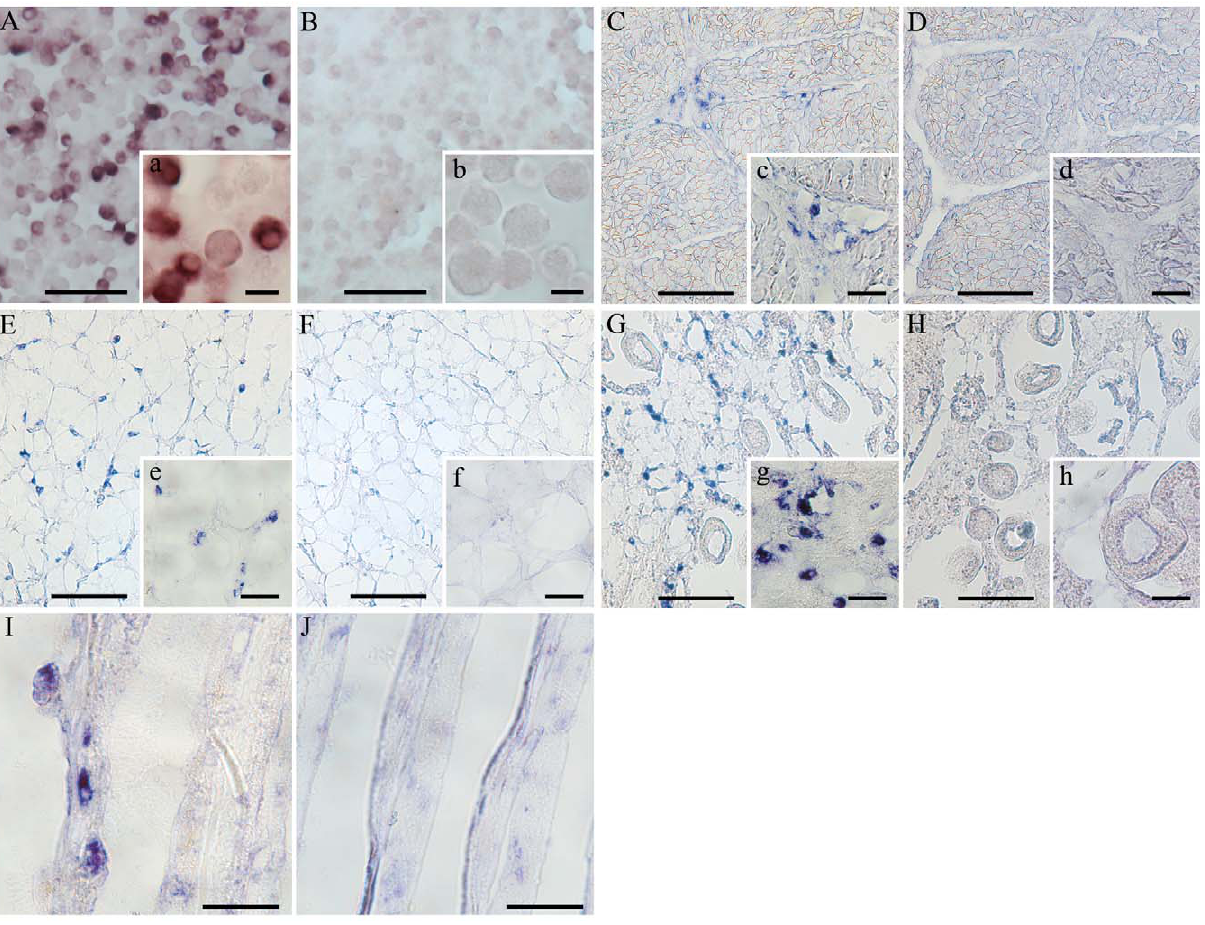
Figure 1. Myt C expression in mussels at the mRNA level. ISH in hemocytes, muscle, connective tissue, gonad and gills from mussel using the myticin antisense RNA probes (A, C, E, G and I, respectively). Control samples were hybridized with the sense probes (B, D, F, H and J, respectively). Scale bar: 50 m m in all cases except in a and b (12.5 m m).